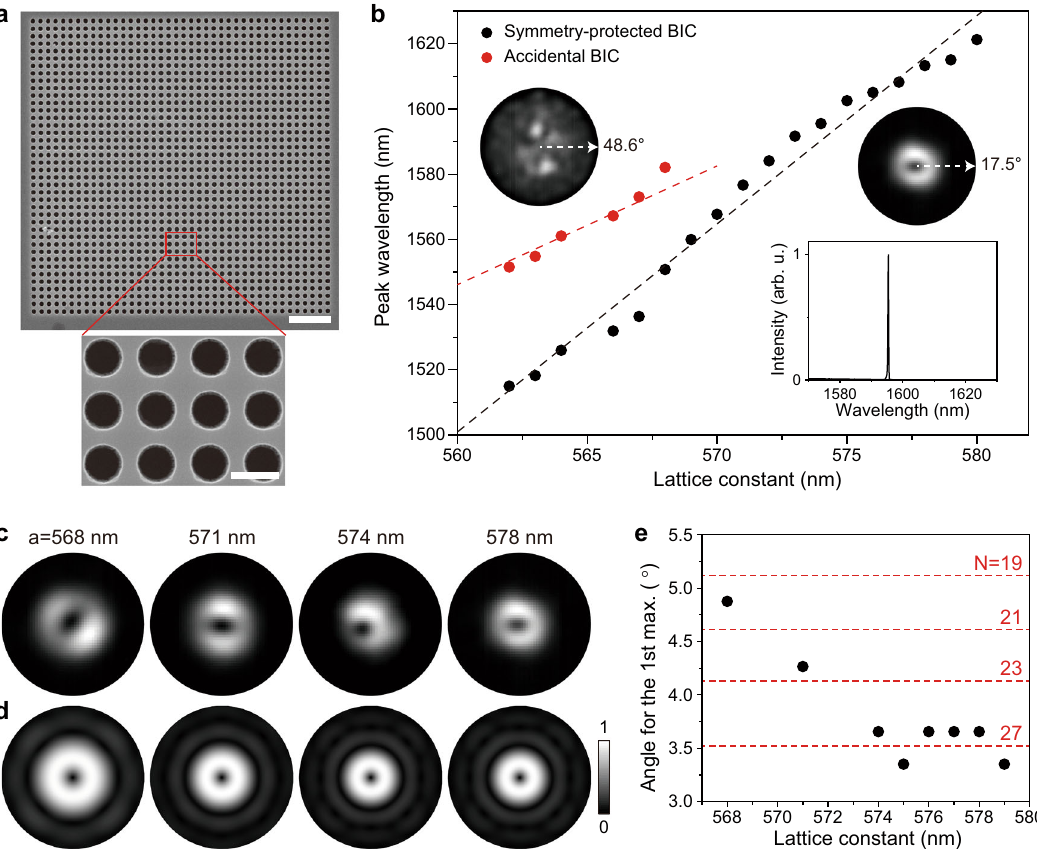
Fig. 3 Characteristics of BIC lasers. a SEM images of the fabricated laser structure with a = 563 nm consisting of 40 × 40 unit cells. The scale bars are 3 μ m (top) and 500 nm (bottom). b Measured lasing wavelengths of the symmetry-protected BIC lasers (black dots) and accidental BIC lasers (red dots) as a function of the lattice constant. The insets show the measured far- fi eld images of the accidental BIC lasing mode (left; a = 568 nm) and the symmetry- protected BIC lasing mode (right; a = 578 nm). The bottom inset shows the above-threshold spectrum at a = 574 nm. Merging of the BICs occurs at a ~574 nm. c Measured far- fi eld images of the symmetry-protected BIC lasers at a = 568nm, 571 nm, 574 nm, and 578 nm (from left to right). The outer circle indicates 17.5°. d Simulated far- fi eld images (| E | 2 ) of the symmetry-protected BIC modes at a = 568 nm, 571 nm, 574 nm, and 578 nm (from left to right). The number of air holes ( N ) varies in the simulation (from left to right): N = 19, 23, 27, and 27. The outer circle indicates 17.5°. e Estimated angle for the 1st intensity maximum in the measured far- fi eld images of the symmetry-protected BIC lasing modes (black dots). The red dashed lines indicate the calculated angles with varying N